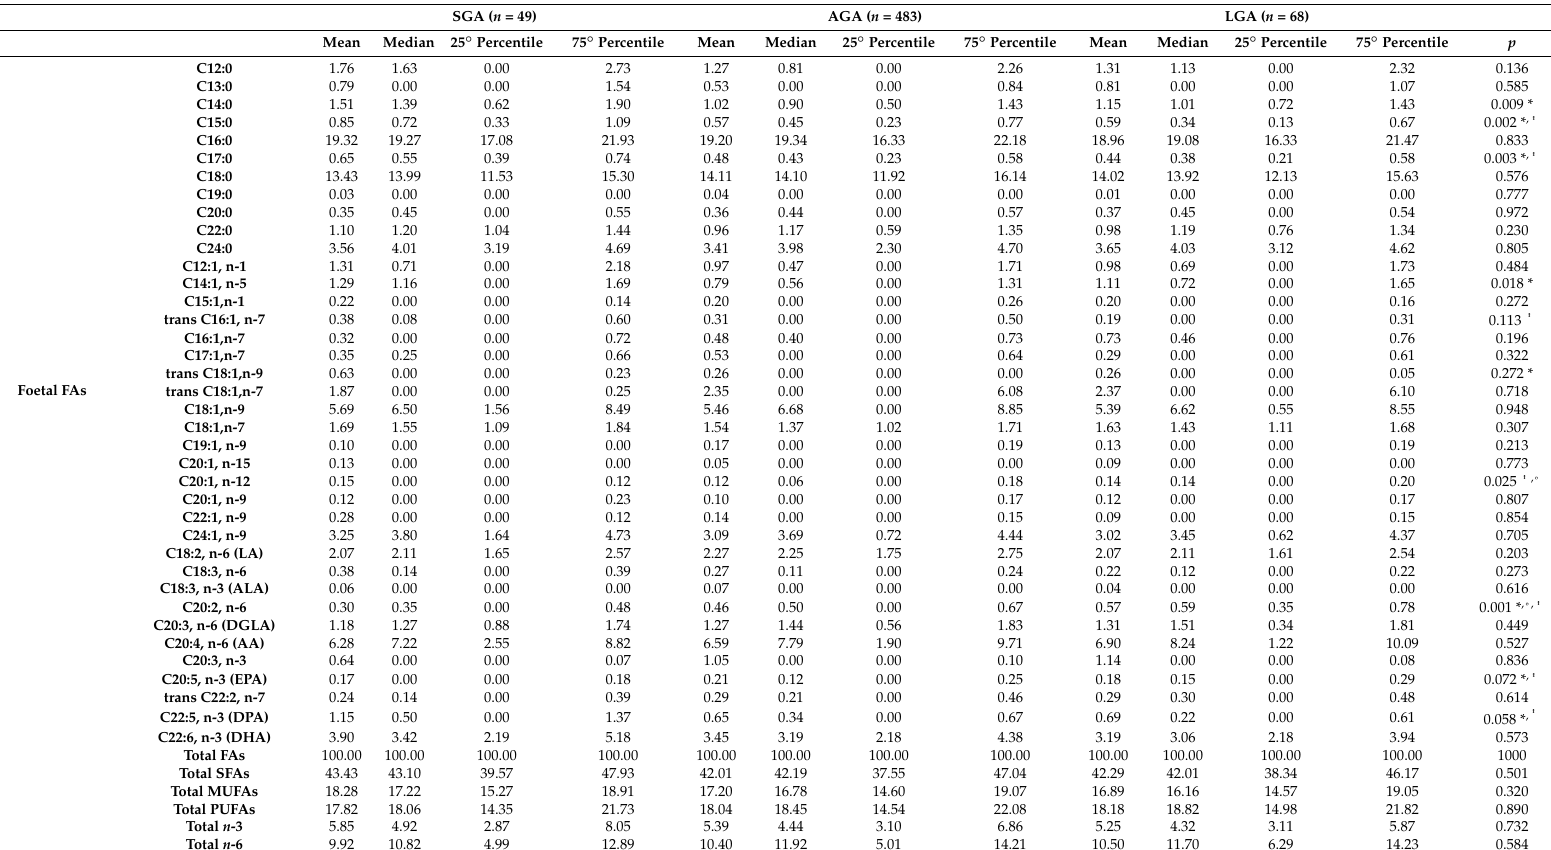
Table 4. Foetal lipid profile in Small for Gestational Age, Adequate for Gestational Age, and Large for Gestational Age